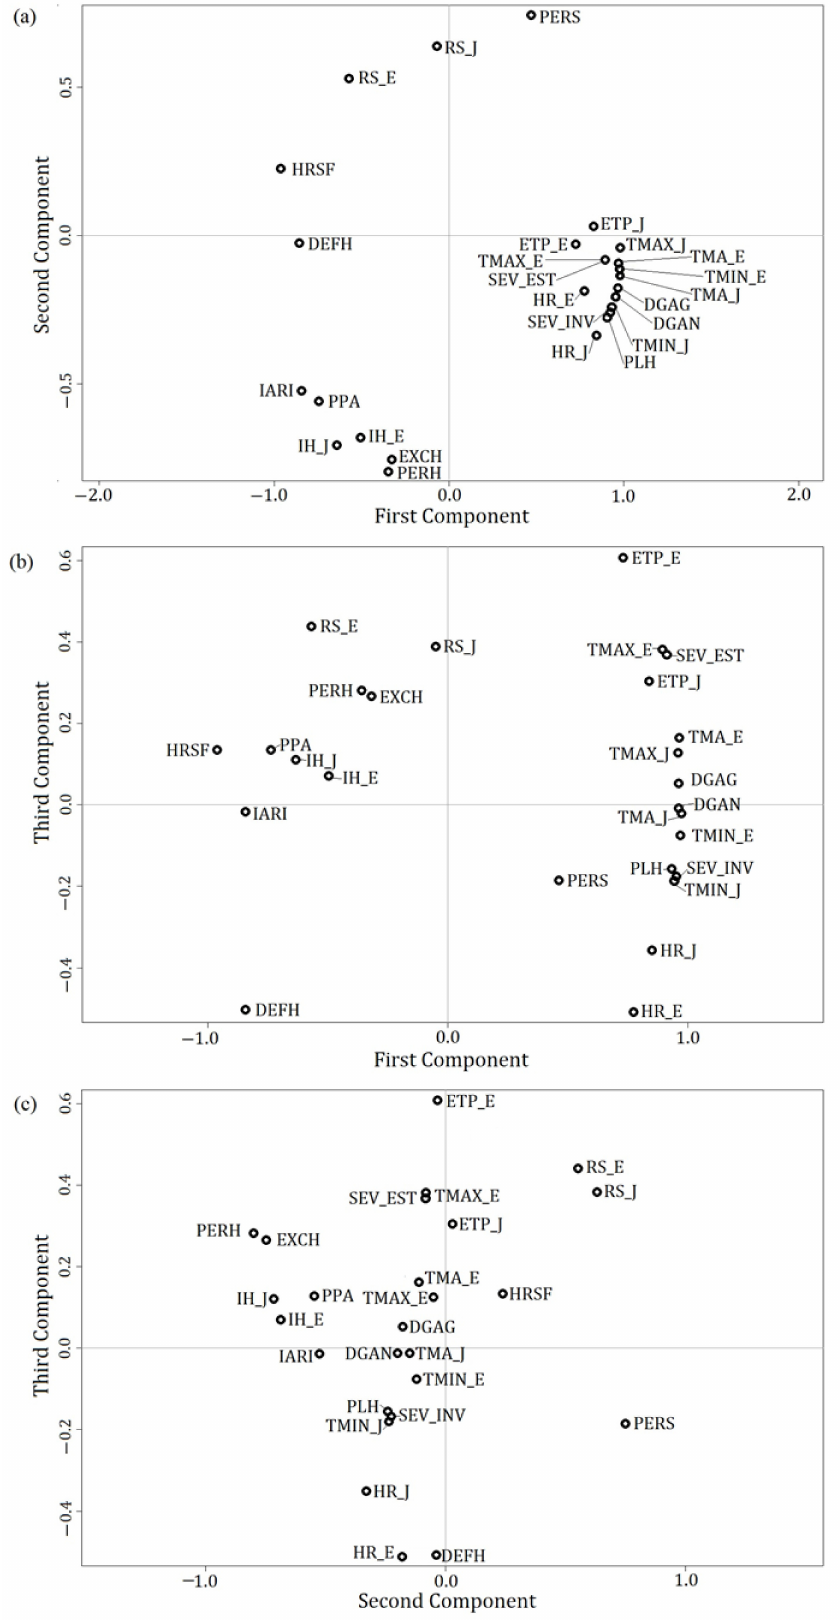
Figure 3. Correlations diagram between components and climate variables of ( a ) components 1 and 2; ( b ) components 1 and 3; and ( c ) components 2 and